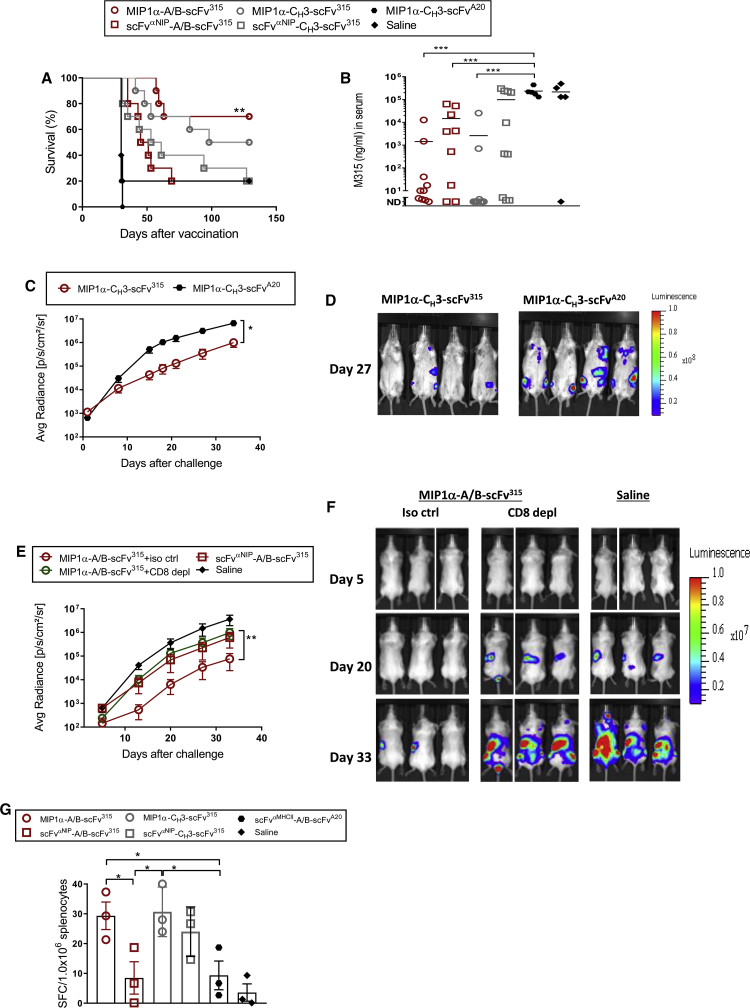
A MIP1α-Targeting A/B Heterodimeric DNA Vaccine Induces T Cell Responses and Protection against an i.v. Challenge with Bone Marrow-Homing MOPC315.BM Multiple Myeloma Cells(A) Mice were vaccinated with 100 μg (A/B heterodimer, two plasmids) or 50 μg (CH3-based homodimer, one plasmid) of DNA i.m./EP. After 14 days, mice were challenged i.v. with 104 MOPC315.BM cells. Survival curves of the vaccinated mice (n = 5–10/group; **p < 0.01, Mantel-Cox analysis, targeting compared with non-targeting groups). (B) Blood samples were harvested on day 36 after challenge and analyzed for the myeloma protein M315 in ELISA (mean; ***p < 0.001, Mann-Whitney test, two-tailed; ND, not detectable). (C and D) Mice were immunized i.m. with 50 μg of DNA/EP. 2 × 105 MOPC315.BM.Luc tumor cells were injected i.v. 14 days later. (C) Luminescence emitted from tumor cells (mean of dorsal and ventral side) as a function of time (n = 7 for MIP1α-CH3-scFv315 and n = 4 for MIP1α-CH3-scFvA20, mean ± SEM; **p < 0.01, two-way ANOVA). (D) Ventral bioluminescent signals in representative mice on day 27 after challenge. (E and F) Mice were immunized i.m. with 100 μg (two plasmids) of DNA/EP. Starting from day 12, mice were injected every other day for 14 days and after that once a week with 100 μg of depleting mAb against CD8 or isotype control (iso ctrl) mAbs. 2 × 105 MOPC315.BM.Luc tumor cells were injected i.v. on day 14 after vaccination. (E) Luminescence emitted from tumor growth sites (mean of dorsal and ventral sides) as a function of time (n = 6 for MIP1α-A/B-scFv315 iso ctrl and scFvαNIP-A/B-scFv315; n = 8 for MIP1α-A/B-scFv315 CD8 depleted; n = 4 for NaCl, mean ± SEM; **p < 0.01, two-way ANOVA for comparison of CD8-depleted and iso ctrl groups at day 33). (F) Dorsal bioluminescent signals in representative mice in the MIP1α-A/B-scFv315 vaccinated group of either the iso ctrl or CD8-depleted group, and saline group (n = 3), taken on days 5, 20, and 33 after challenge. (G) M315 L-chain (λ2315)-specific TCR-transgenic CD4+ T cells (3 × 106) were transferred i.v. to BALB/c mice, followed the next day by the indicated vaccinations (i.m.). After 11 days, spleens were harvested and analyzed for IFN-γ-secreting T cells (ELISPOT) after stimulation with a MHCII-restricted λ2315 CDR3 peptide (ALWFRNHFVFGGGTKVT, amino acids 91–107). The spleens were pooled within the groups (n = 4/group) and run in technical triplicate (mean ± SEM; *p < 0.05, Mann-Whitney test, one-tailed).